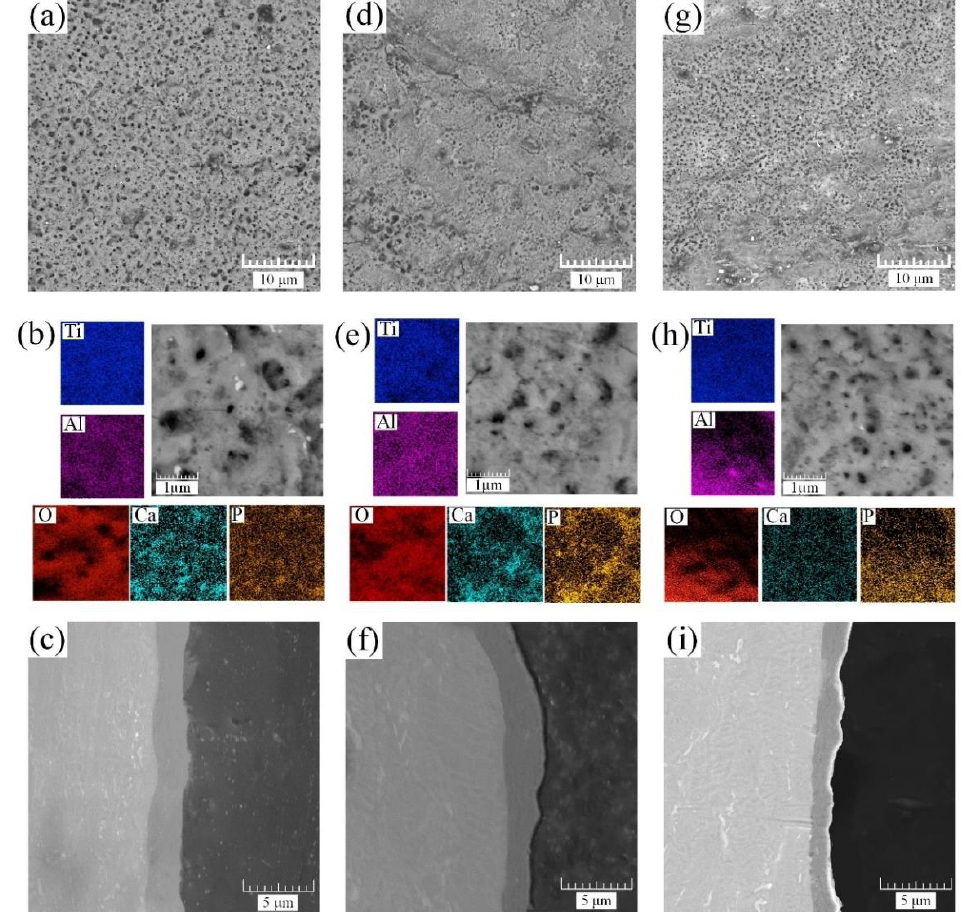
Figure 3. SEM images of the morphology and cross-section of the surfaces of the coated titanium alloys with elemental mapping: ( a – c ) S1; ( d – f ) S2; ( g – i ) S3. Color scale for determining the chemical elements: Blue — Ti; purple — Al; green — Nb; red — O; turquoise — Ca; yellow — P.